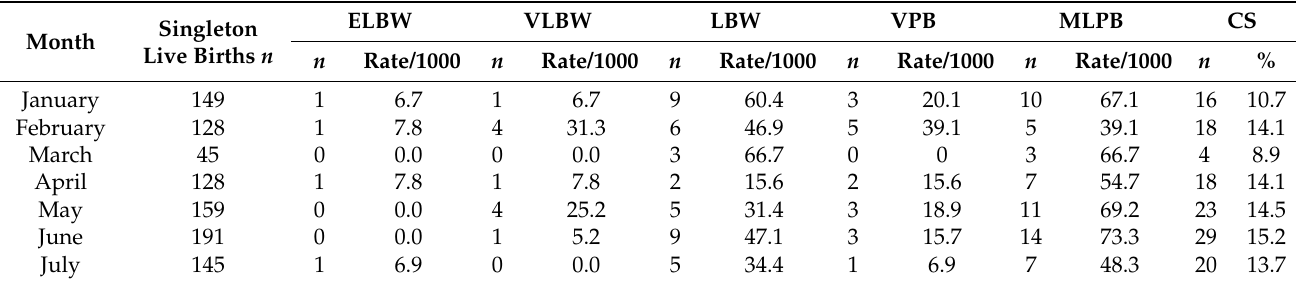
Table 2. Rates of ELBW (<1000 g), VLBW (<1500 g), LBW (1500–2500 g), VPB (<32 weeks) MLPB (32–36 week) and CS at the Danube Hospital between January and July 2020.